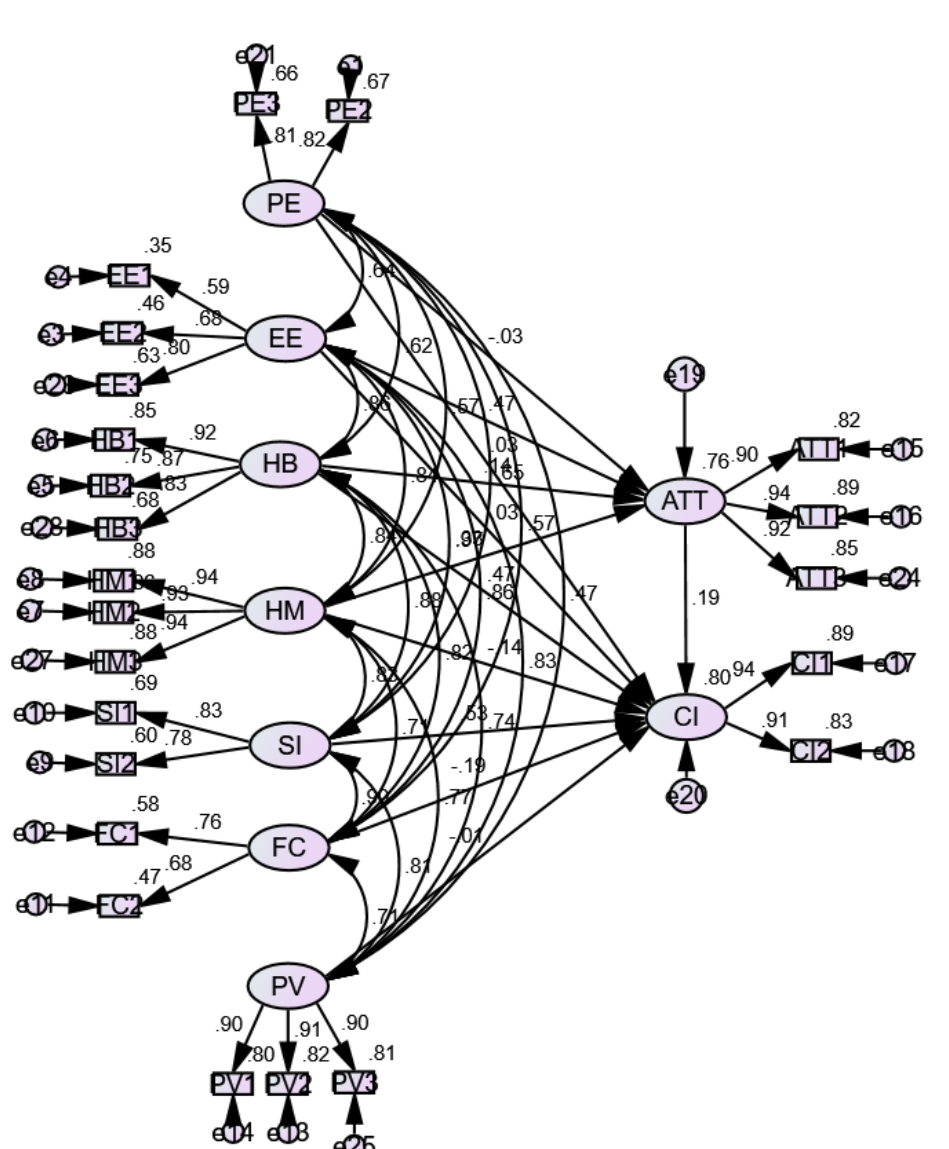
Figure 3. The SEM for the proposed model. Note: PV = price value, FC = facilitating conditions, SI = social influence, HM = hedonic motivation, HB = habit, EE = effort expectancy, PE = performance expectancy, ATT = attitude, and CI = continuous intention.